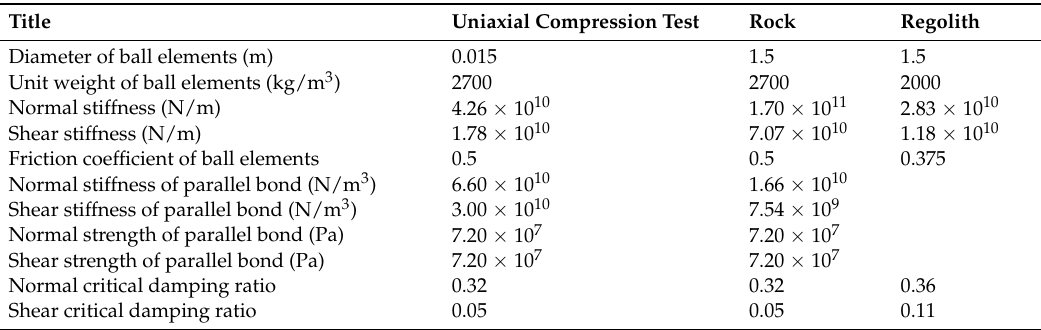
Table 3. Parameters of field case simulations.